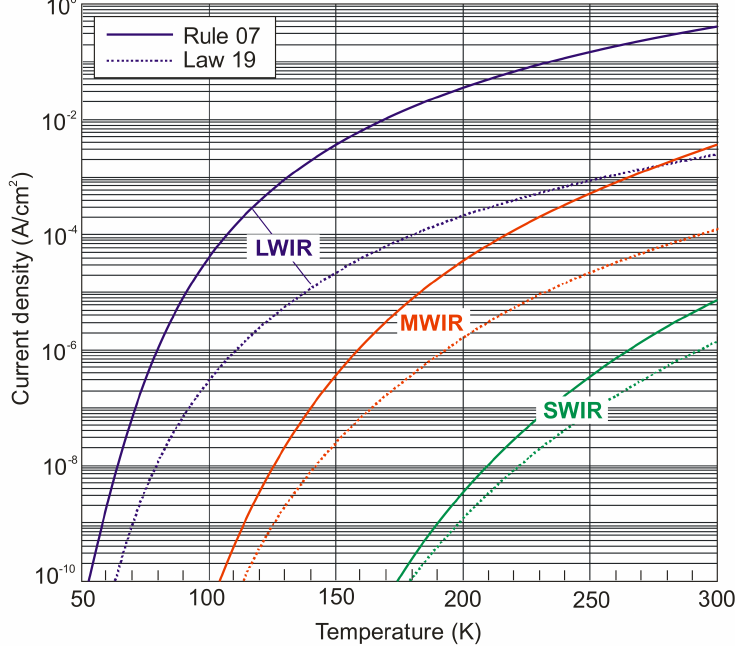
Figure 5. Calculated current density versus temperature using Law 19 and Rule 07 for SWIR ( λ c = 3 µ m), MWIR ( λ c = 5 µ m), and LWIR ( λ c = 10 µ m) HgCdTe